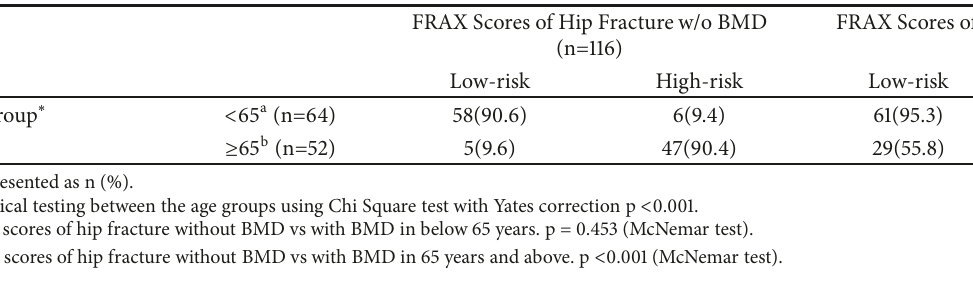
Table 5: The 10-year probability of hip fracture stratified by age.